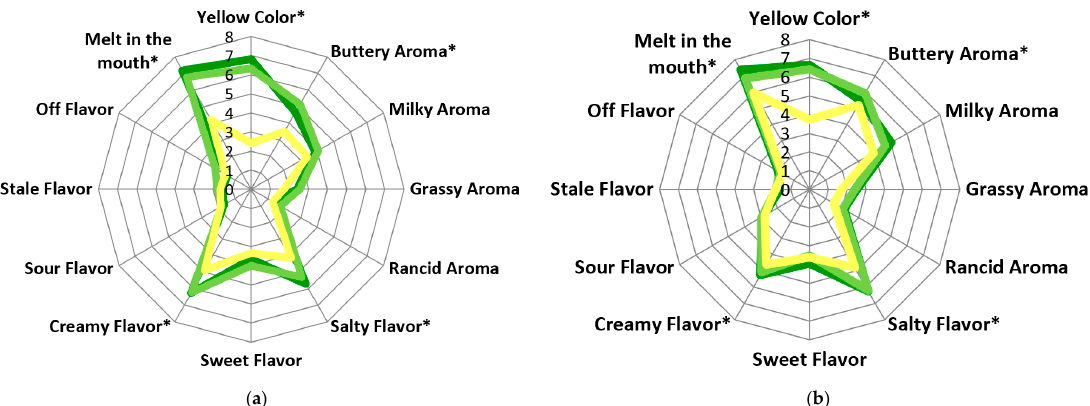
Figure 1. Average results ( n = 20) from ranking descriptive analysis evaluation of FS-GRSS, FS-CLVR and FS-TMR butters by Irish ( a ) and German ( b ) assessors. * p < 0.05.